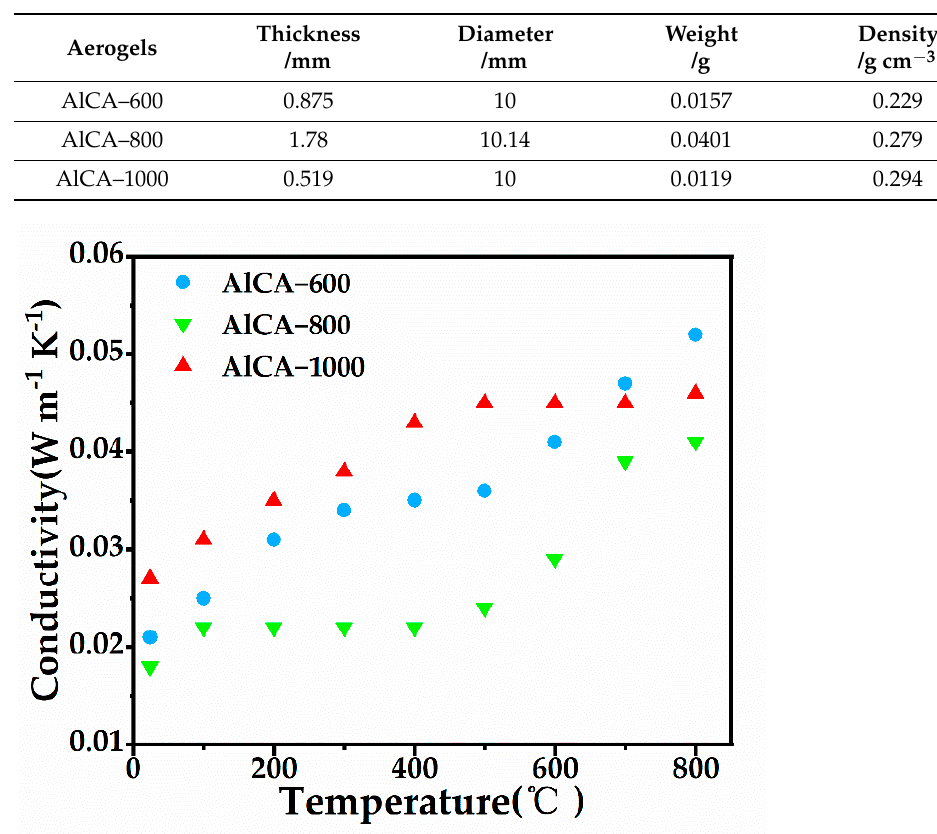
Figure 4. Thermal conductivity of AlCAs.